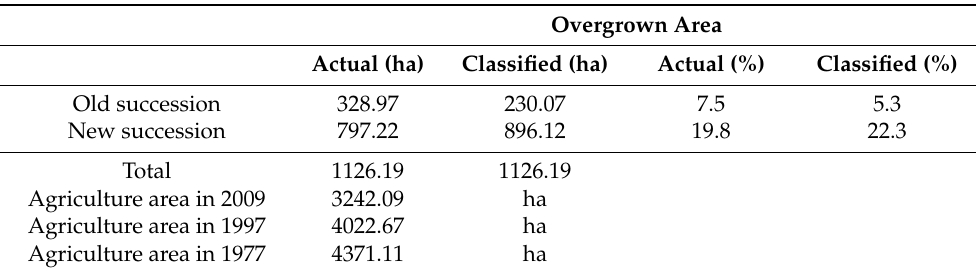
Table 3. Comparison of actual and classified overgrown area in relation to agricultural land not overgrown at the beginning of the analyzed